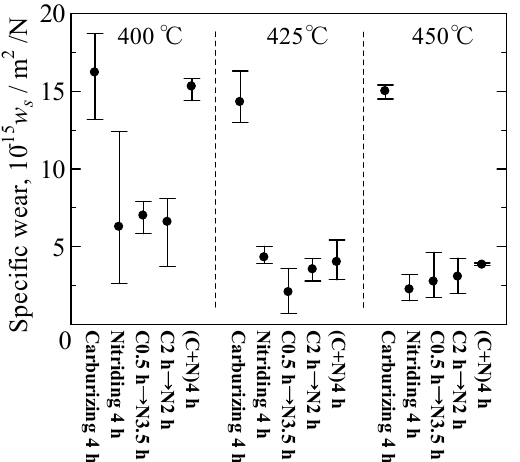
Figure 8. Hardness of the S-phase layers on cold-sprayed AISI 316L coatings subjected to various low-temperature plasma treatments at different temperatures.